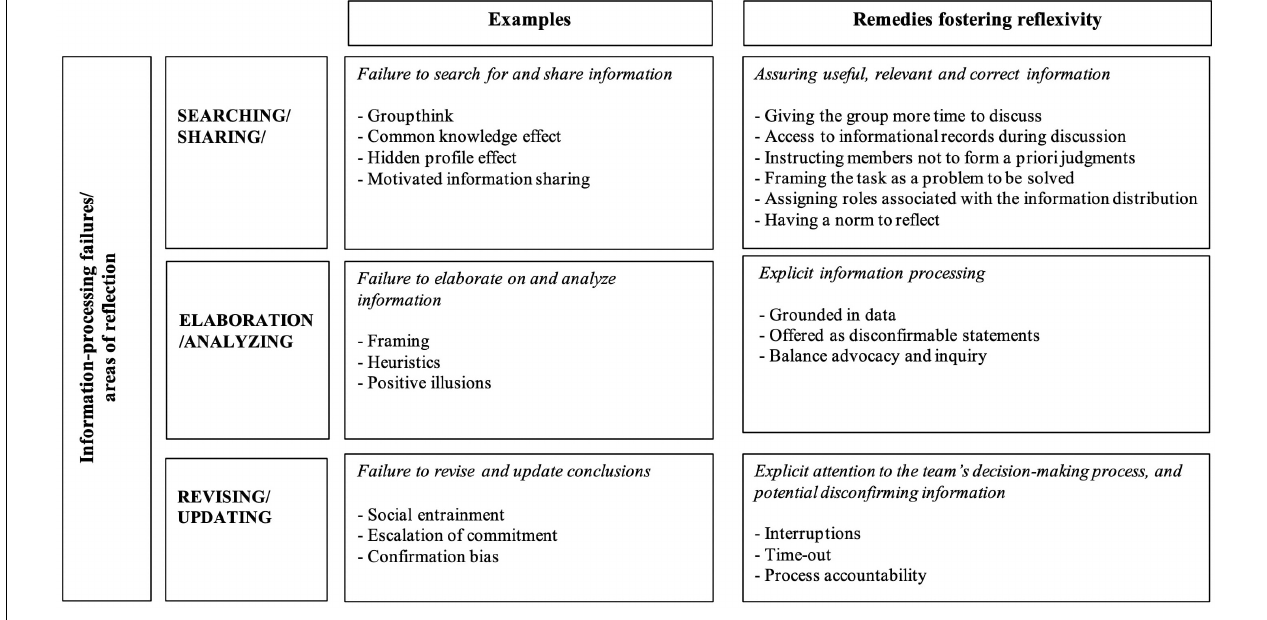
FIGURE 1 | Information processing failures and remedies fostering reflexivity. Adapted from Schippers et al.